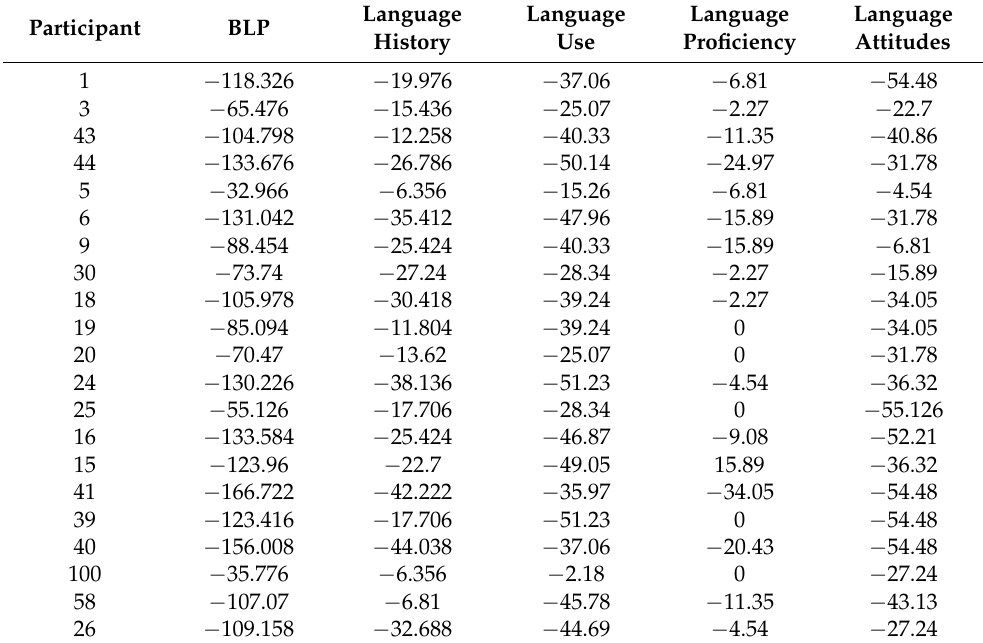
Table A3. BLP: language history, language use, language proficiency and language